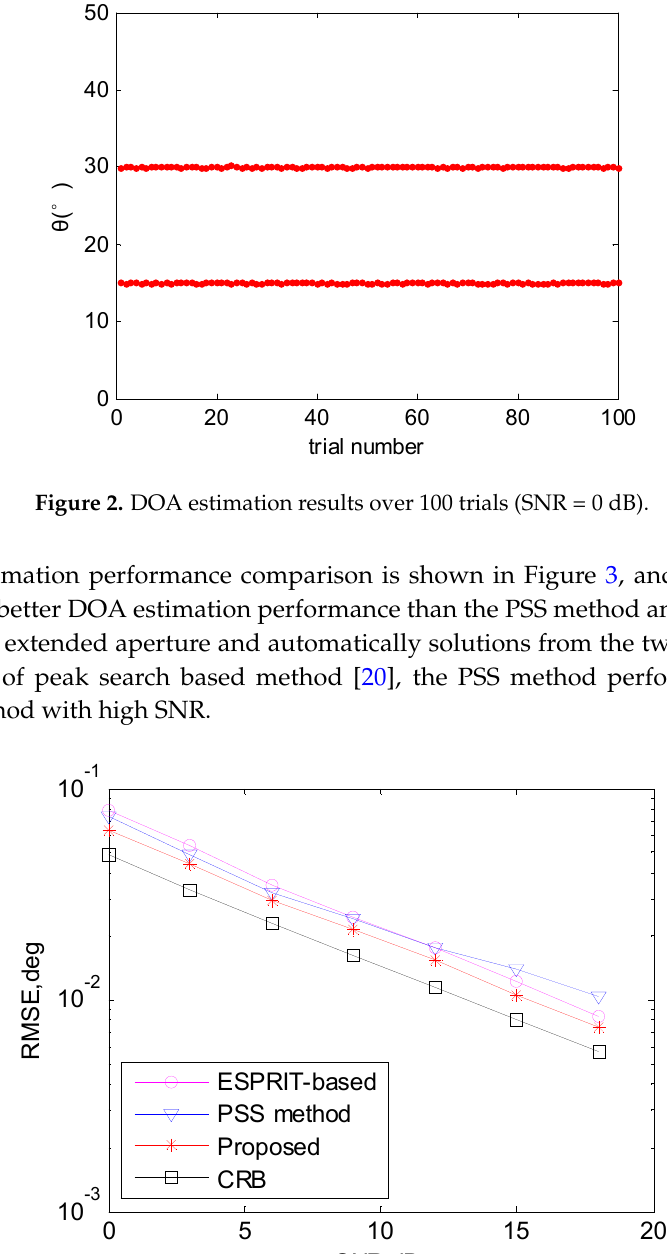
Figure 4. DOA estimation results with K = 5 sources (SNR = 10 dB). In Figure 5, we show the DOA estimation performance comparison with two closely-spaced sources, whose DOAs are